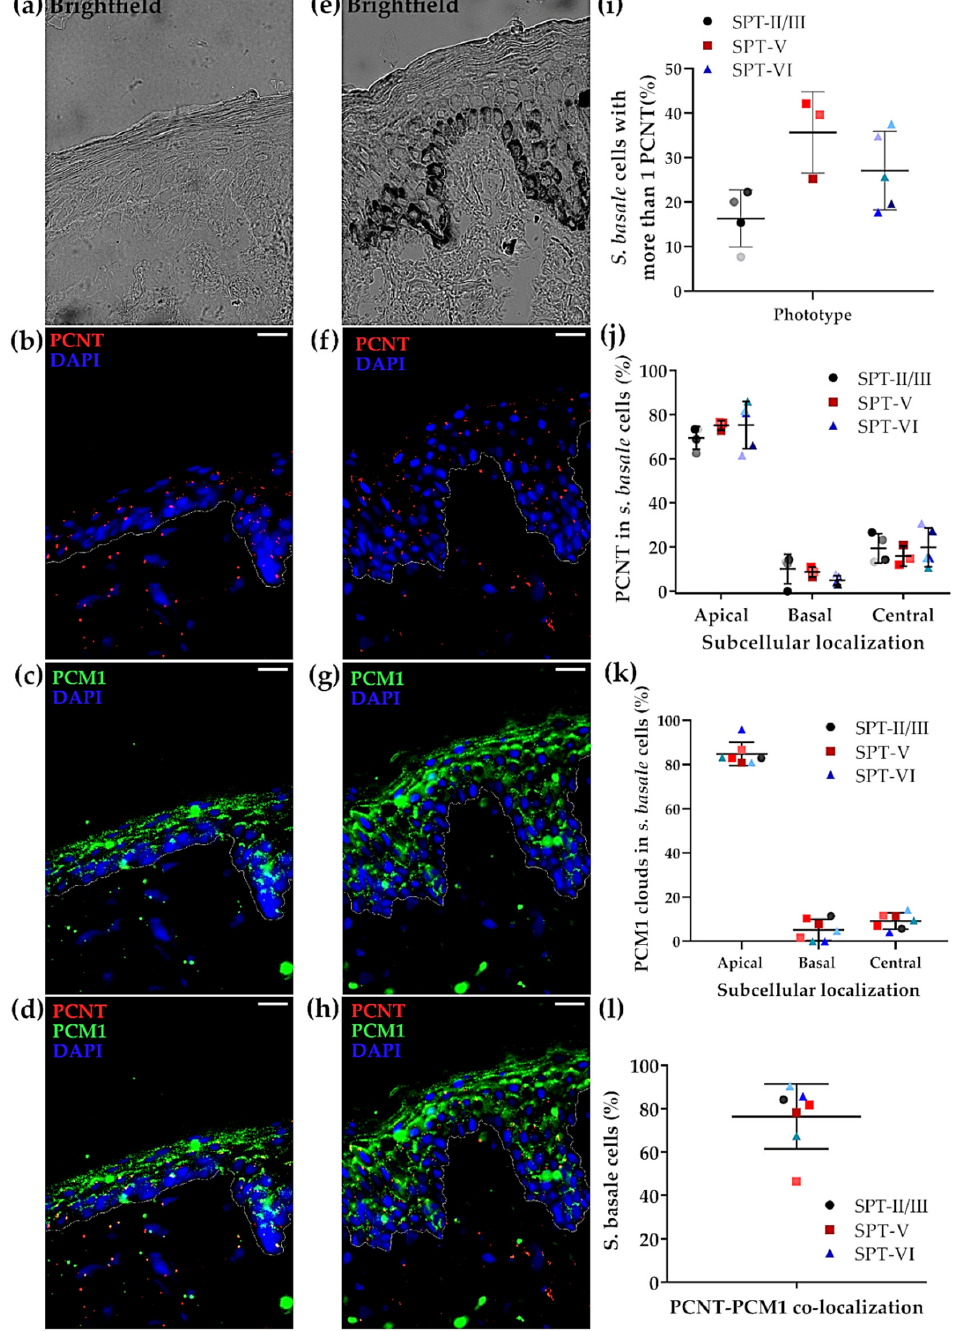
Figure 4. Centrosome (PCNT) and Centriolar satellites (PCM1) in low vs. high SPT skin. Representative images (scale bar = 20 µm) of SPT-II/III human skin tissue; ( a ) brightfield image showing low level of pigmentation, ( b ) in situ localisation of centrosomes (PCNT in red) and ( c ) centriolar satellites (PCM1 in green). ( d ) Merged image of b and c. Representative images of SPT-VI human skin tissue; ( e ) brightfield image showing high level of pigmentation, ( f ) in situ localisation of PCNT in red and ( g ) PCM1 in green. ( h ) Merged image of f and g. ( i ) Quantification of S. basale KCs with more than one centrosome. Graph shows the percentage (%) of S. basale KC with more than one centrosome (i.e., PCNT dot) in SPT-II/III (black), V (red) and VI (blue) human skin. No significant differences were found using one-way ANOVA test (each dot represents the summary data for one donor, n = 12). ( j ) Quantification of subcellular localisation of centrosomes. Graph shows the percentage (%) of the total centrosomes (PCNT dots) that showed an apical, basal and perinuclear/central localisation in SPTII/III (black), SPTV (red) and SPTVI (blue) human skin. No significant differences were found using multiple t -test (each dot represents the summary data for one donor, n = 12). ( k ) Quantification of subcellular localisation of